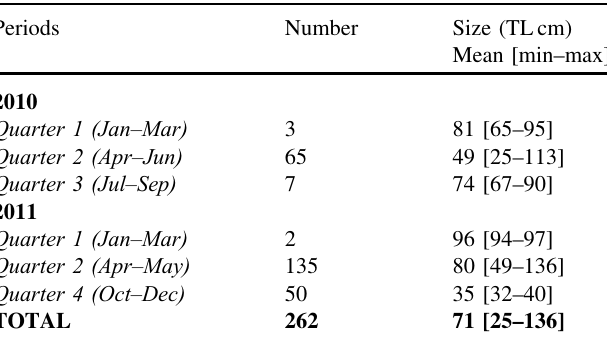
Fig. 1. Map of the Bay of Biscay with FAO fi shing areas. Stars indicate fi sh auction markets where meagres have been sampled (CM: Charente-Maritime, AC: Arcachon Bay, PA: Table 1. Summary of meagre sampled for stomach content analysis.